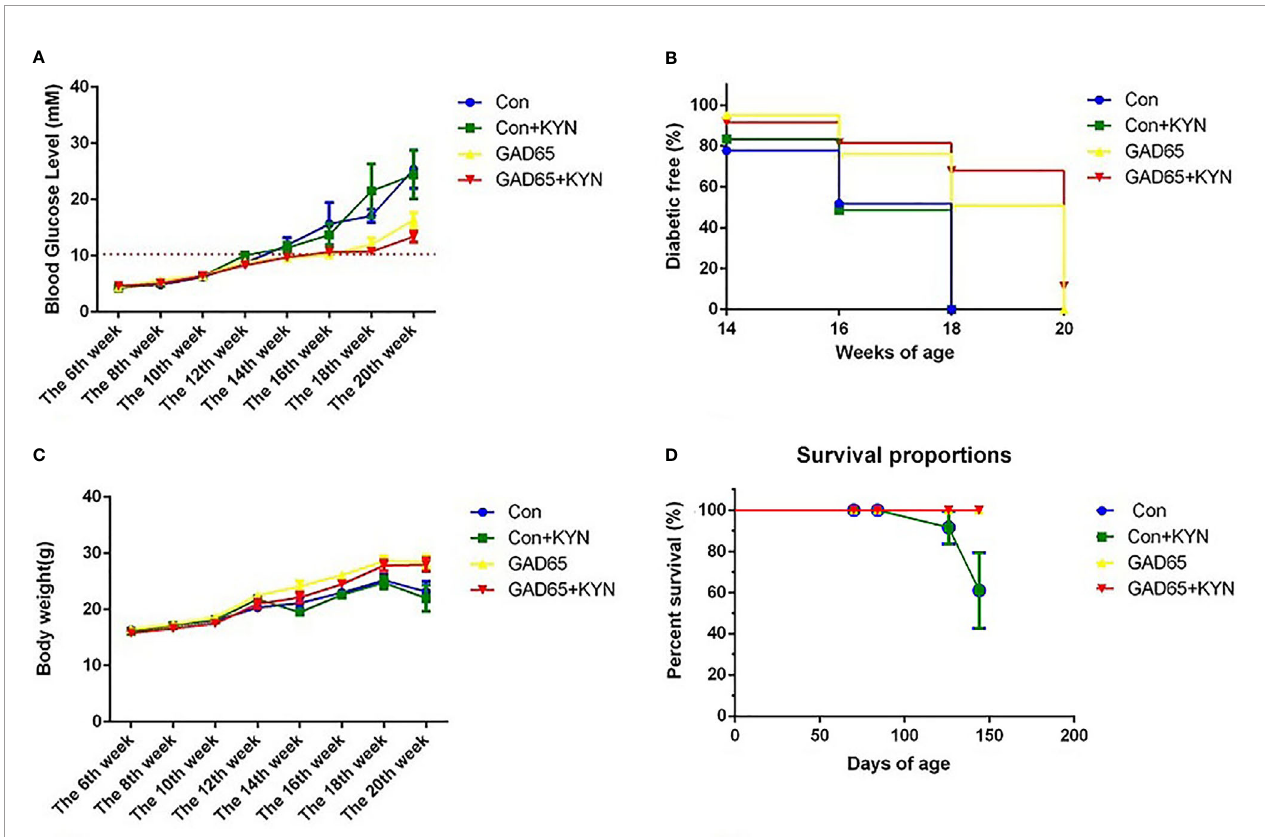
FIGURE 2 | NOD mice were immunized with phage vaccine with or without KYN on weeks 10 and 12. (A, C) Blood glucose/body weight was measured on weeks 6, 8, 10, 12, 14, 16, 18, and 20. The body weight of mice grew when treated with GAD65 phage vaccine with KYN. (B) Mice immunization of GAD65 phage vaccine with KYN were signi fi cantly remission from hyperglycemia in 60% at least one month. (D) The survival